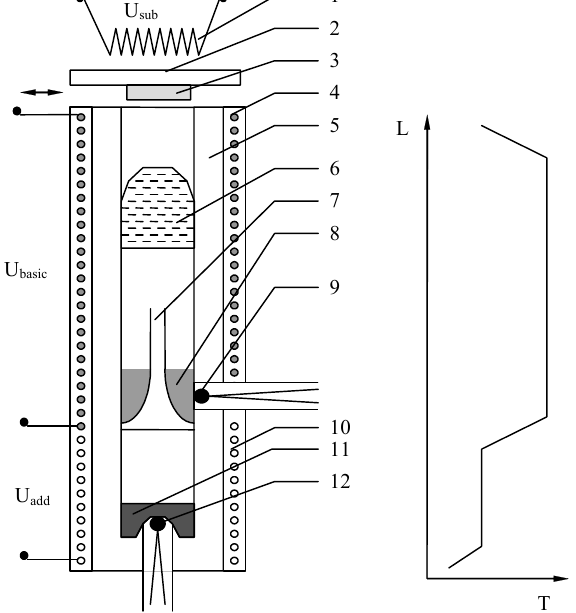
Figure 1. Scheme of reactor layout (left) and temperature distribution in it (right): 1—substrate heater; 2—holder of substrates; 3—substrate; 4—heater of the main steam source; 5—metal screens for leveling the temperature gradient; 6—damper divider; 7—capillary; 8—main load; 9—main charge thermocouple; 10—additional source of steam; 11—additional source of thermocouple; 12—heater of an additional source (U sub —substrate heater voltage, U basic and U add —main and additional heaters voltage of the reactor chamber walls, L—the length of the reactor zone,